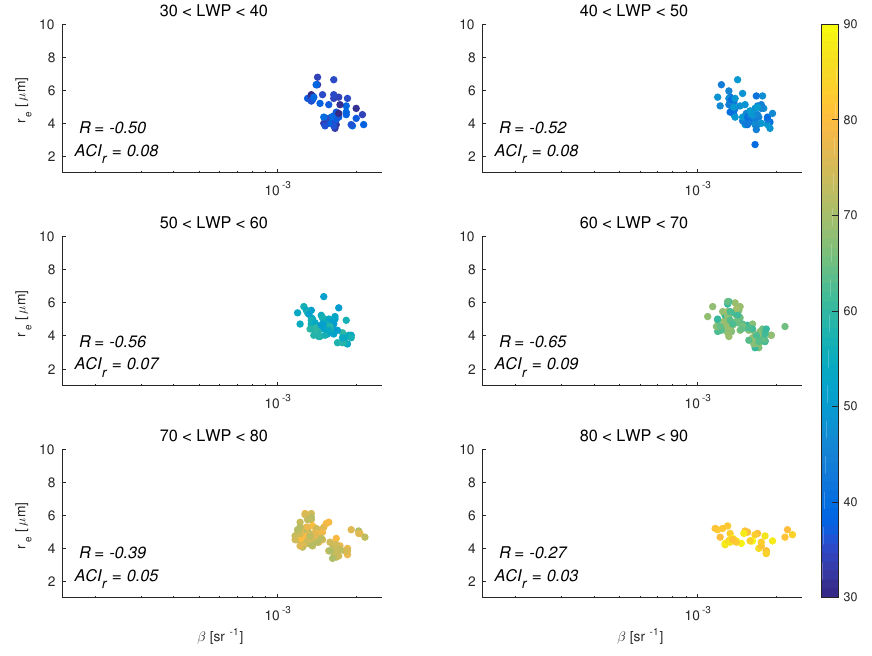
Figure 6. The values of the effective radius, r e , derived from WACR and MWR measurements are plotted versus the integrated attenuated backscatter ATB measured by Vaisala CT25K on 29 November 2009. Data are sorted by the values of LWP from the MWR. Every panel shows the corresponding value of ACI r (Eq. 5) and the Pearson product-moment correlation coefficient, R , for that LWP